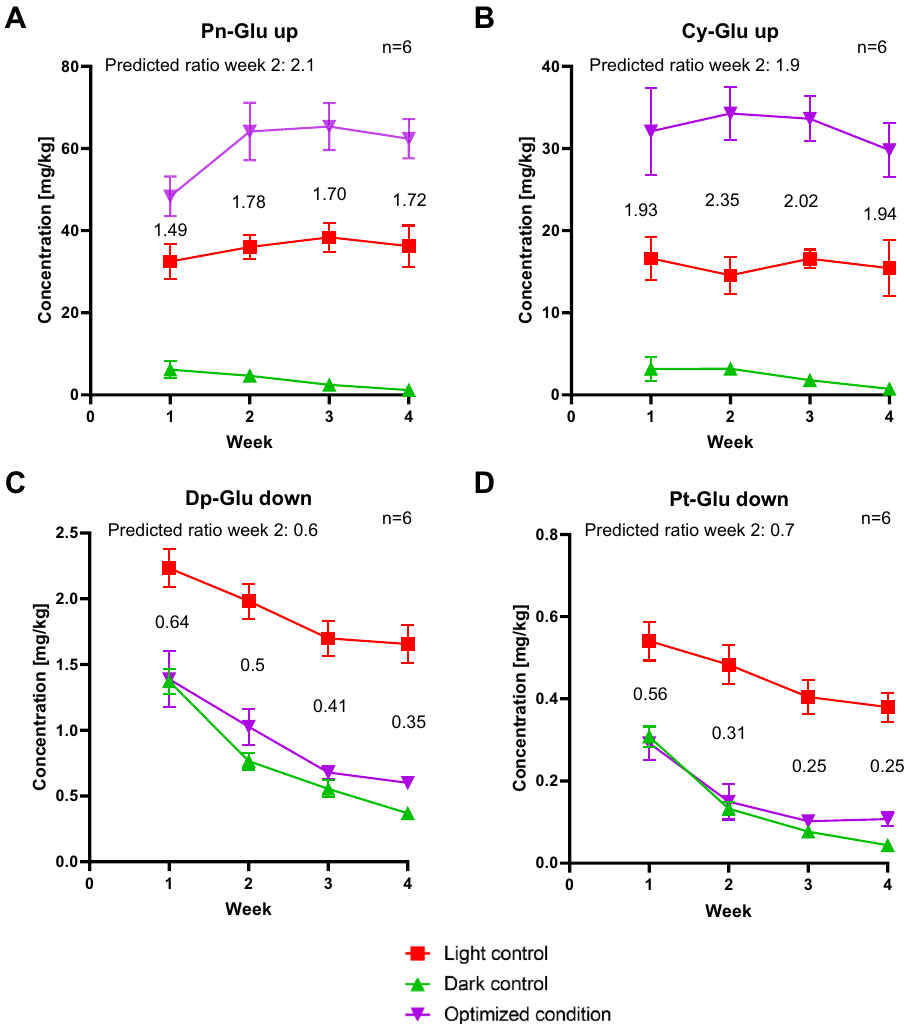
Figure 5. Concentration of four different anthocyanins of grapevine cultures under different lighting conditions during 4 weeks. All cultures originated from the same source culture. All 36 replicate cultures were cultivated for 4 weeks at 26 °C, shaking at 140 rpm. Every week, 15% of the cells (v/v) were subcultured and the remaining cells were collected for LC-IMS-HRMS analysis to determine anthocyanin concentrations. Six cultures per anthocyanin target (see Table 4) were grown under their optimized lighting condition (purple triangle) for upregulation (up) or downregulation (down). Those cultures were cultivated in the LiS under their optimized lighting conditions with a 16-h photoperiod. The six light controls (red square) were cultivated according to the conditions of the routine/source culture (standard shaking incubator, light positioned in the ceiling, 16-h photoperiod, 80 µmol m 2 s 1 ), the six dark controls were cultivated in the absence of light (green triangle). The ratio between the anthocyanin concentrations in the cultures under optimized lighting conditions and the anthocyanin concentrations in the cultures under standard lighting conditions were calculated and are shown in the graphs for every week, as well as the predicted ratio based on the calculations from the main experiment are shown for week 2. Each graph represents a different anthocyanin: ( A ) Peonidin-Glucoside (Pn-Glu), ( B ) Cyanidin-Glucoside (Cy-Glu), ( C ) Delphinidin-Glucoside (Dp-Glu) and ( D ) Petunidin- Glucoside